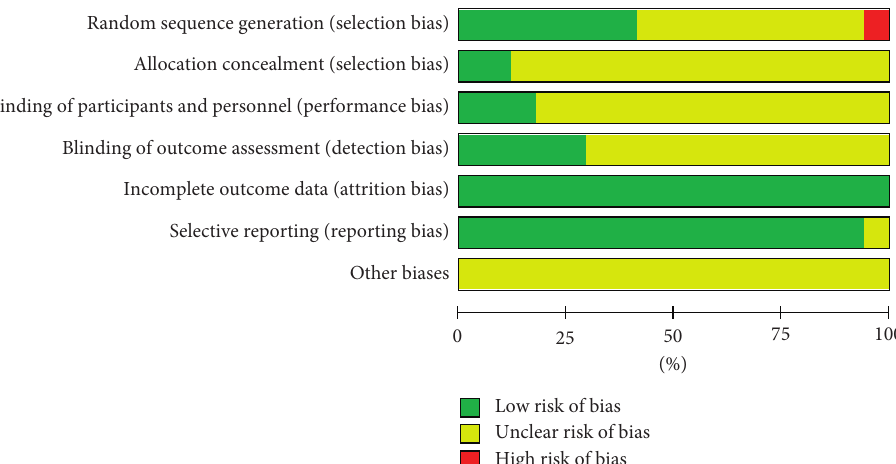
Figure 2: Risk of bias graph: review authors’ judgement about each risk of bias item presented as percentages across all included